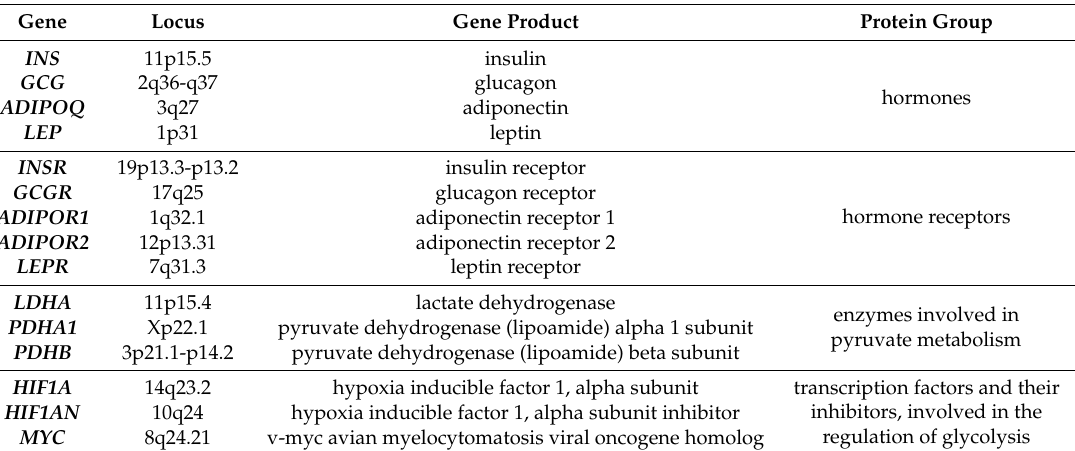
Table 2. Genes of interest selected for the